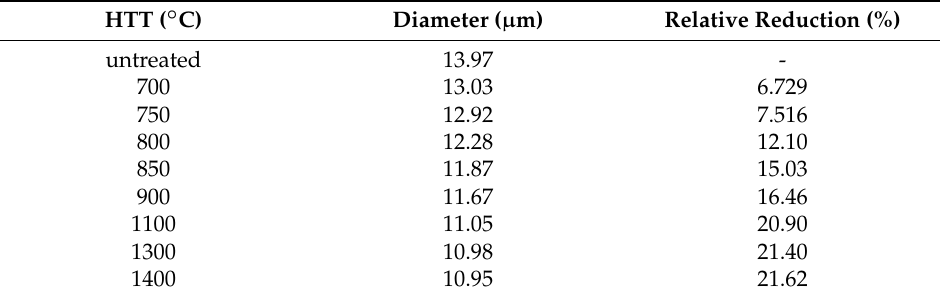
Table 3. Results of diameter measurement.